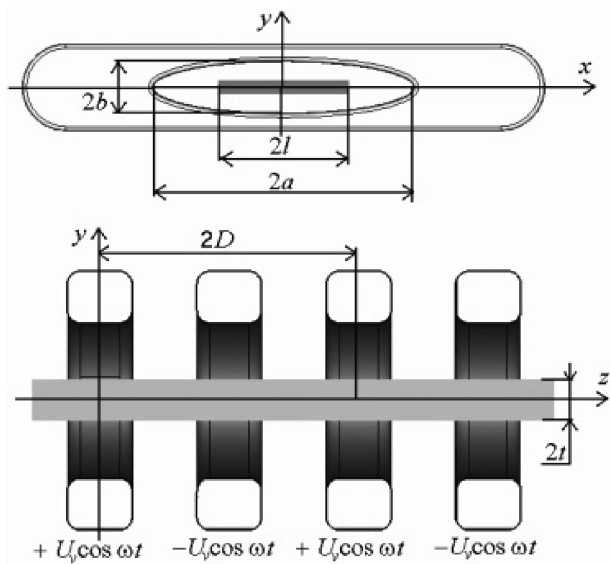
FIG. 1. The general view of the UNDULAC-RF accelerating